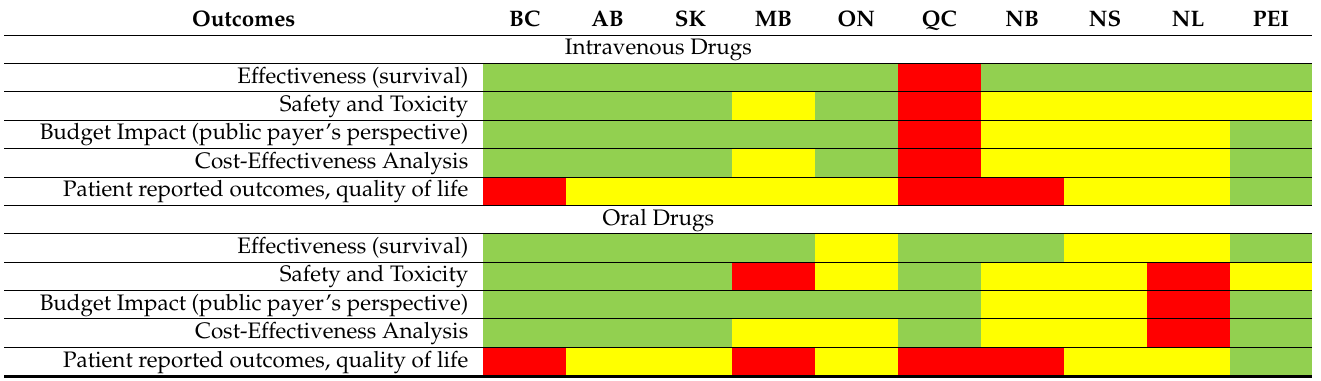
Table 5. Capability assessment for conducting a population-based comparative analysis on intra- venous and oral cancer